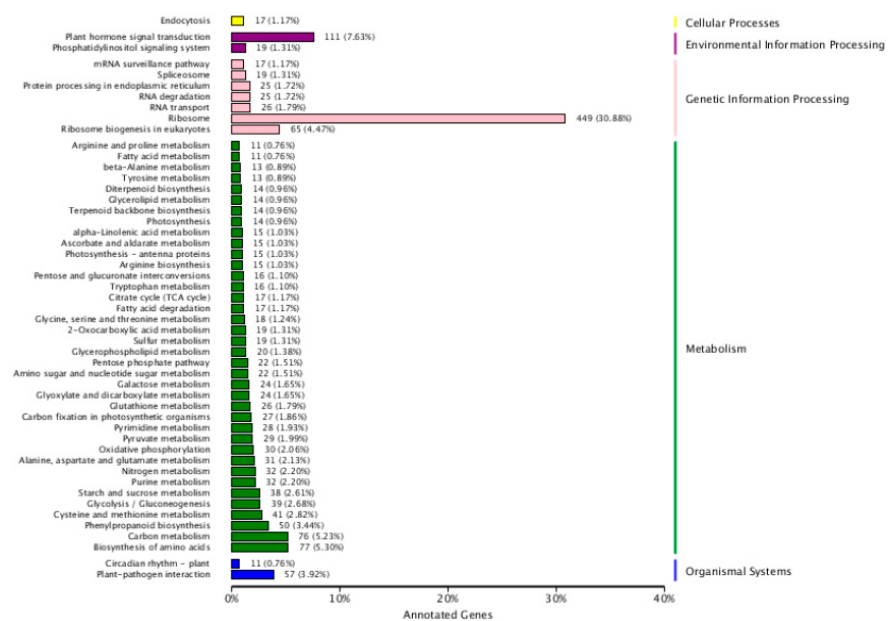
Figure 3. Top five Kyoto Encyclopedia of Genes and Genomes (KEGG) pathways for cotton